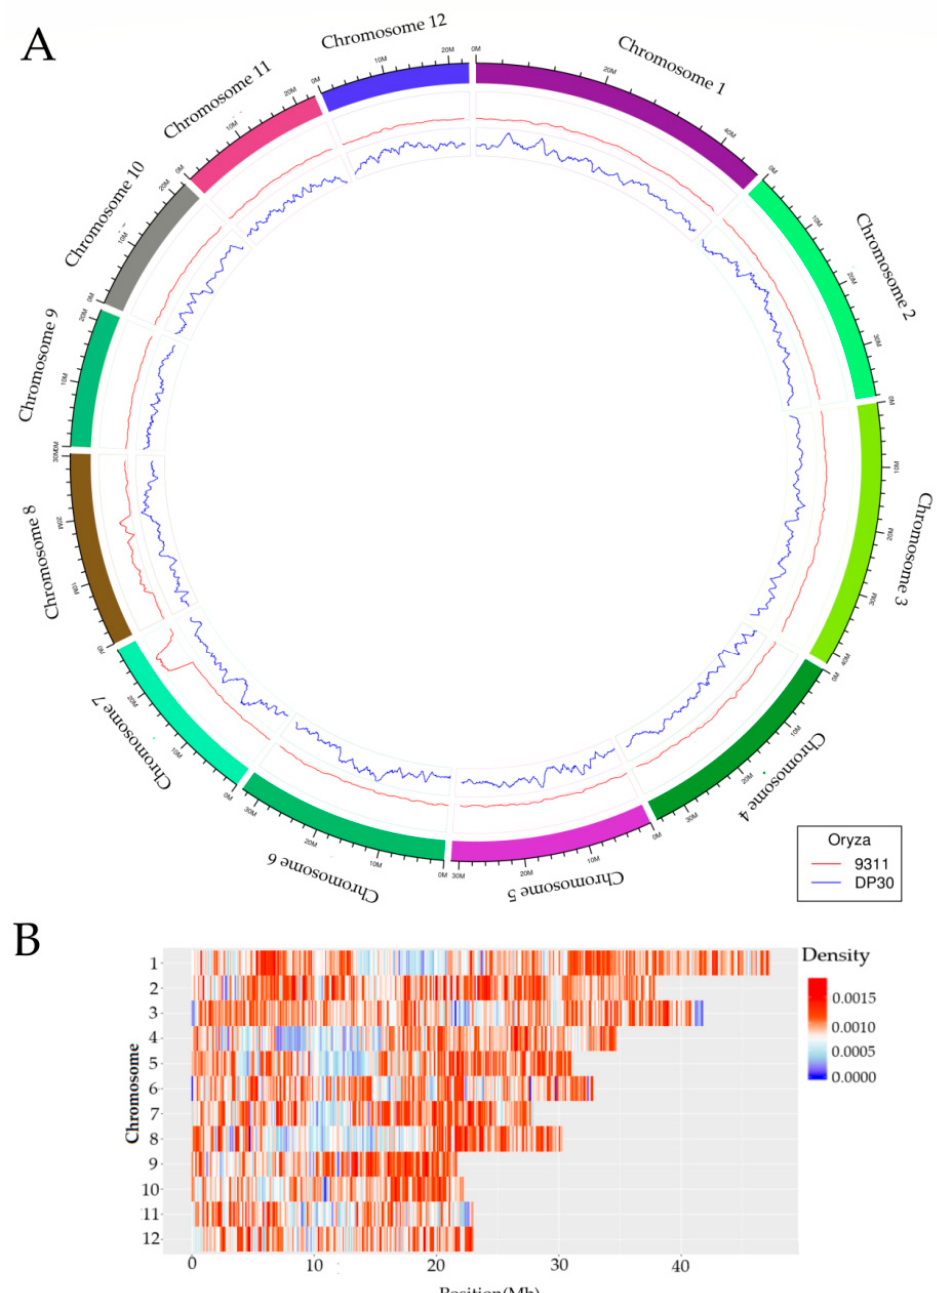
Figure 1. Whole-genome sequencing of DP30 and genome-wide sequence di ff erence. ( A ) Circos plot for SNPs and InDels detected in 93-11 and DP30. The outermost circle depicts the ideogram of the 12 chromosomes in the rice genome. The innermost lines represent the frequency SNPs and InDel markers identified between DP30 (blue) and 93-11 (red); ( B ) genome-wide distribution of sequence di ff erences between 93-11 and DP30. Red and blue colors represent the degree of variation between DP30 and 93-11. Depth of the color indicates the level of variation